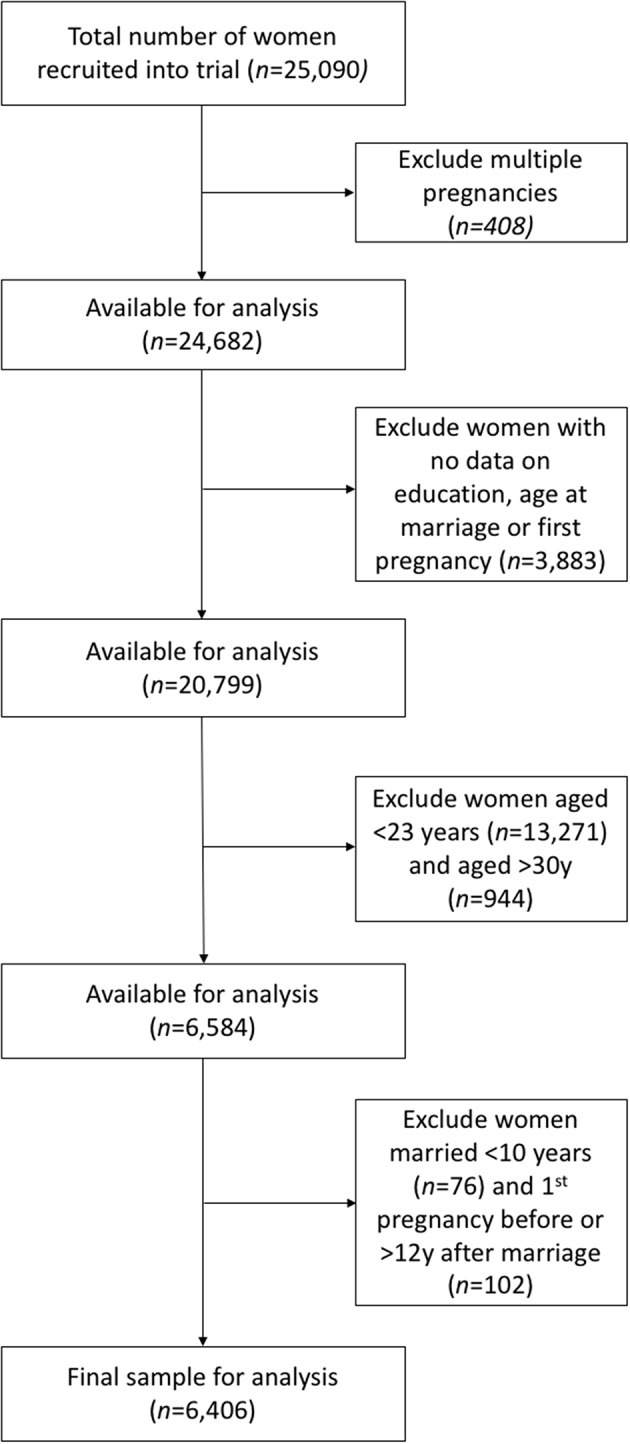
Sample selection. This flowchart illustrates how our sample was selected. Boxes to the left describe the number available for analysis once the exclusions have been accounted for in the boxes to the right.